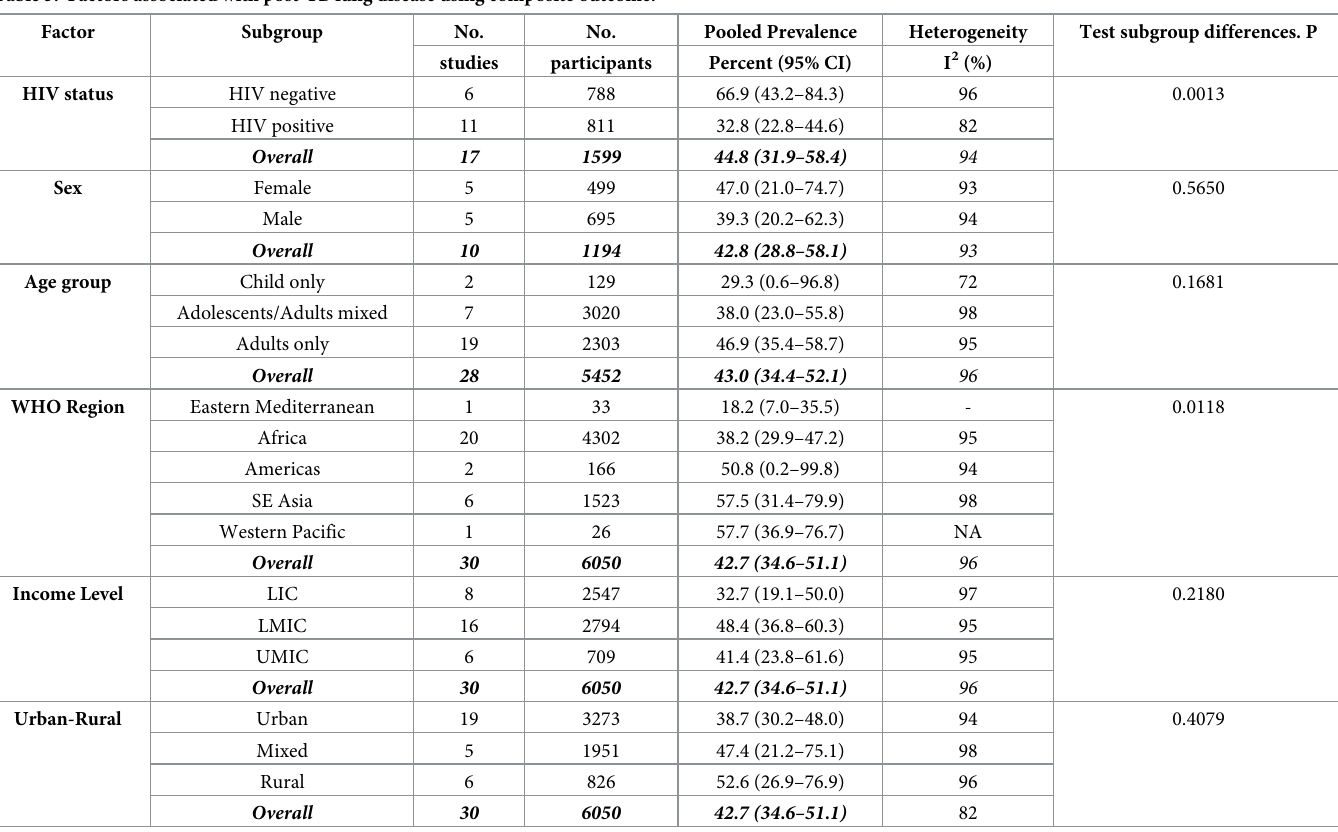
Table 5. Factors associated with post-TB lung disease using composite outcome.